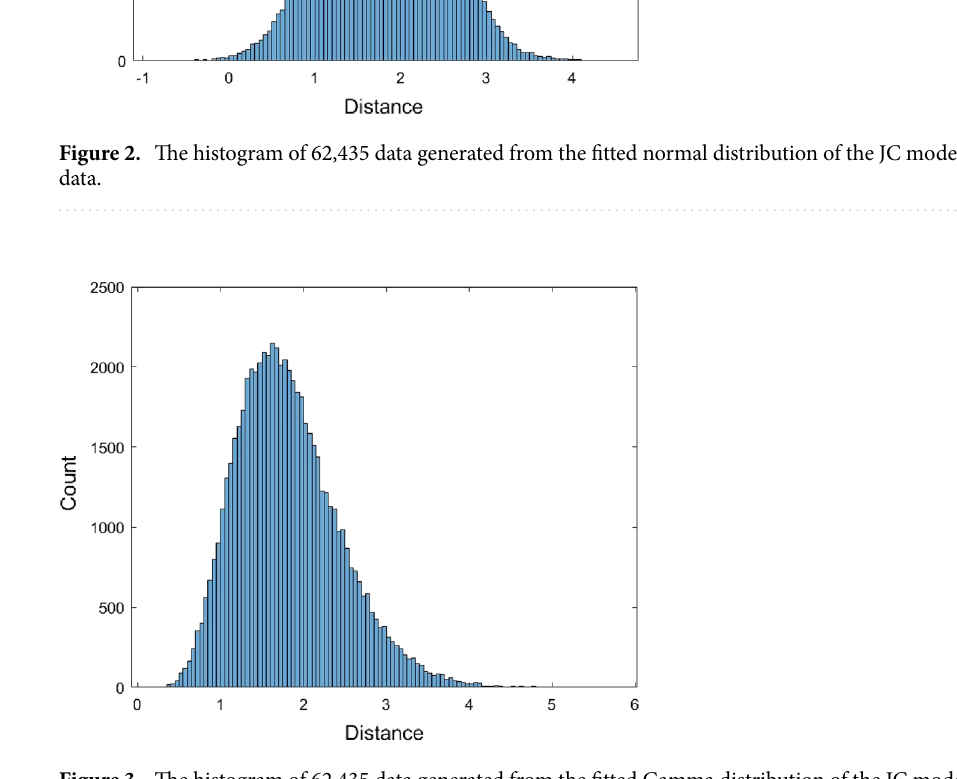
Figure 3. The histogram of 62,435 data generated from the fitted Gamma distribution of the JC model distance